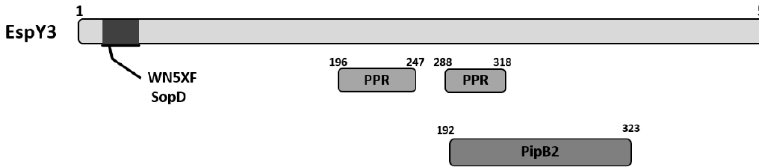
Figure 1. Schematic representation of EspY3 protein domains. EspY3 protein presents a WEX5F domain in the N-terminal region, which group with SopD T3SS-1 effectors family of Salmonella . In addition, EspY3 shows homology to PipB2, a T3SS-2 effector protein of Salmonella .